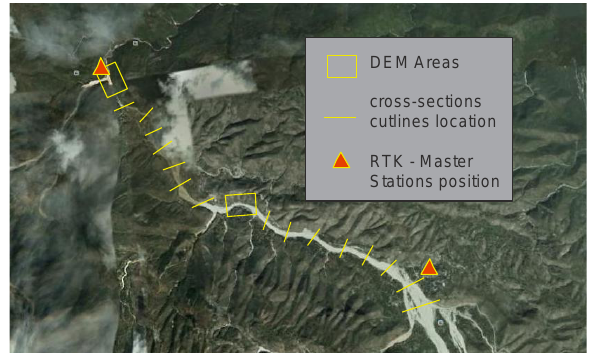
Figure 6. Scheme representing river cross-sections cutlines, the two areas where a high-resolution DEM was needed and the position of the two GNSS Master stations